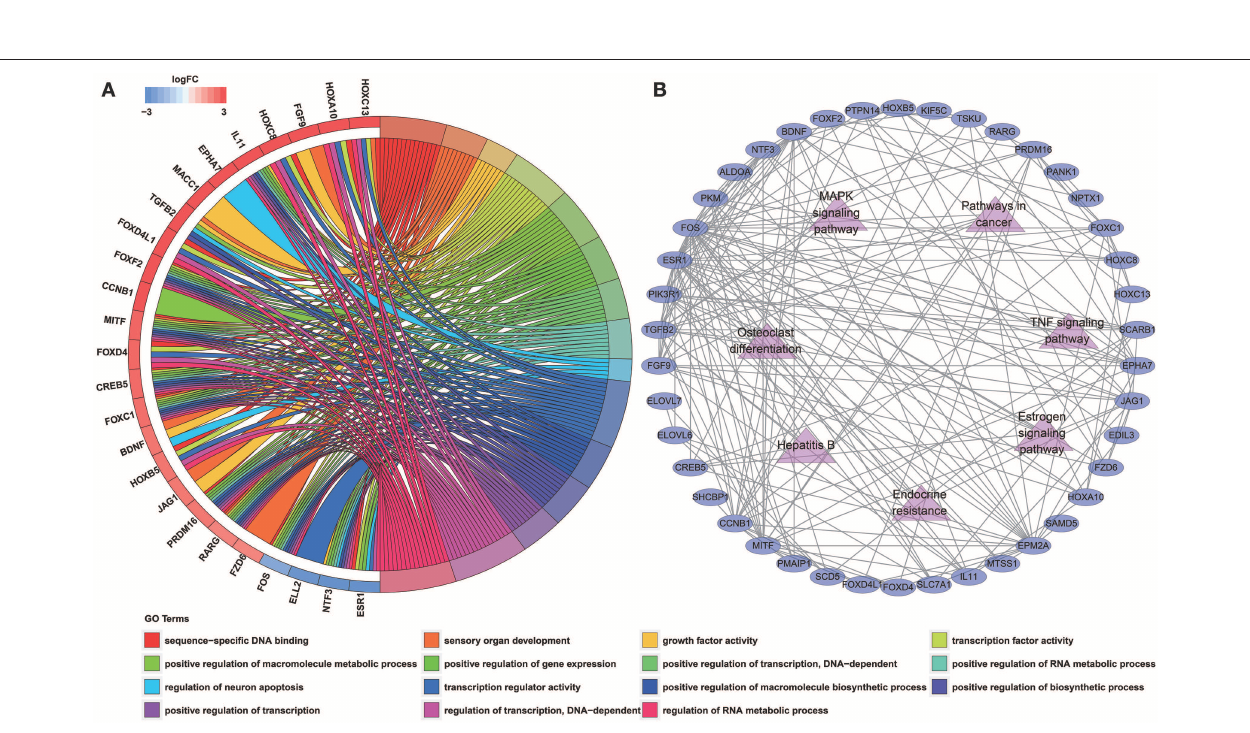
Frontiers in Oncology |